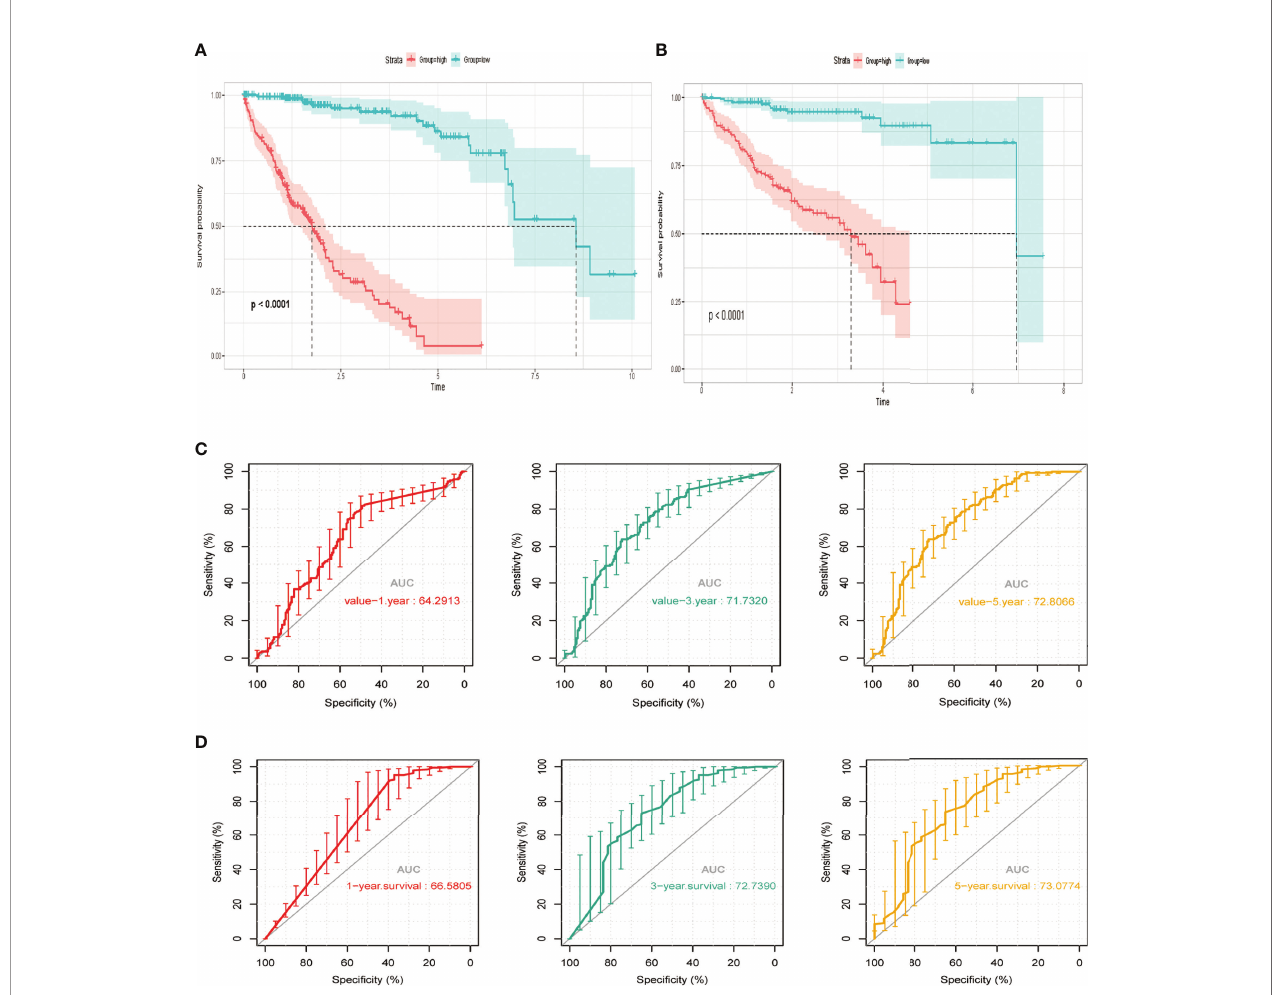
FIGURE 3 | TherisksignatureinHCCfromthetrainingset,theindependentexternalvalidationcohort. (A,C) TheKaplan – MeiercurvesoftheMAPK-RAP1Arelatedrisk signature. (B,D) Time-dependentROCcurvesat1,3,and5years.AUC,areaundertheROC;HCC,hepatocellularcarcinoma;ROC,receiver-operatingcharacteristic.